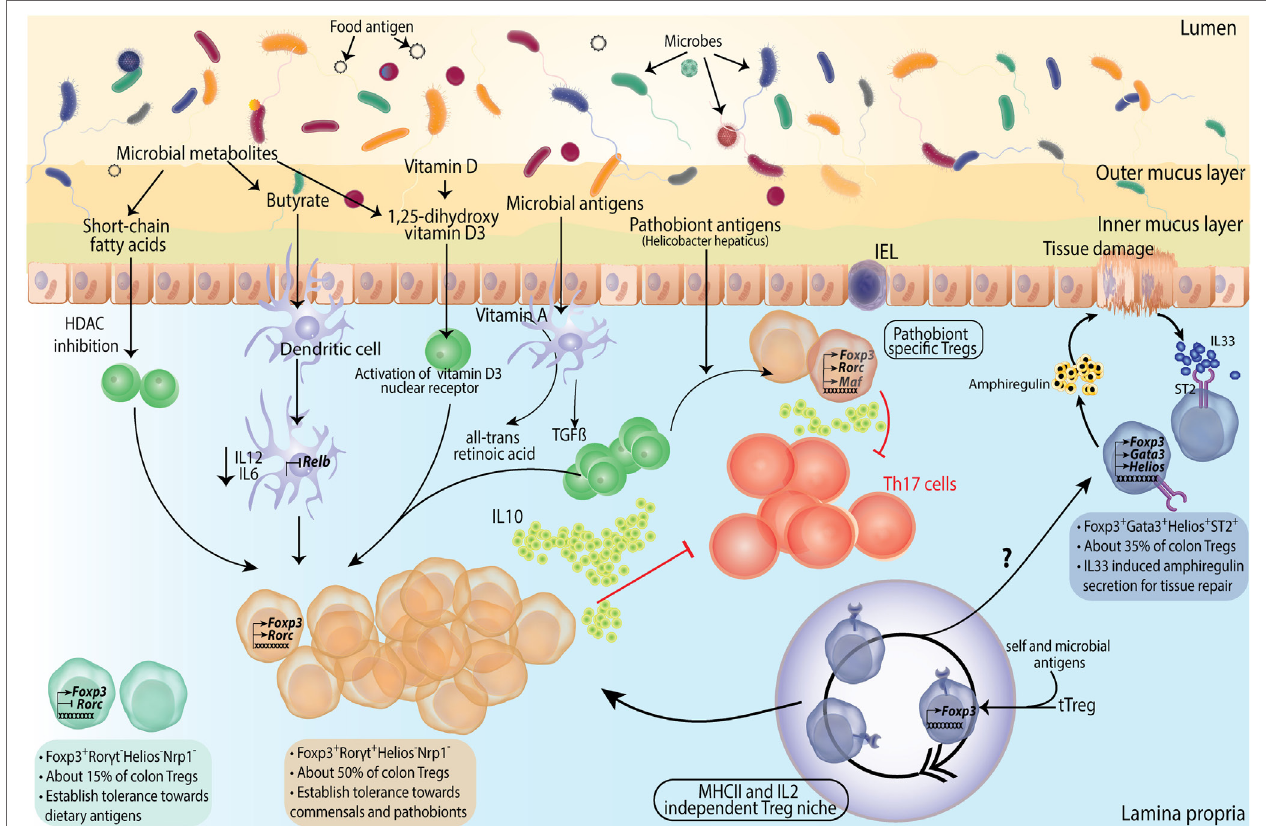
FiGURe 3 | Subtype differentiation of regulatory T-cells (Tregs) in large intestine. Colonic Tregs differentiate into three different subtypes based on ROR γ t (Rorc) and GATA3 expression along with Foxp3. Foxp3 + ROR γ t − cells comprise ~ 15% of colonic Tregs, their function in colon is not much elucidated but presumably these are responsible for establishing tolerance to dietary antigens. Second and major subset of colonic Tregs is Foxp3 + ROR γ t + Tregs, constituting about 50% of total colonic Tregs. These cells are primarily involved in microbial tolerance and several mechanisms contributing to their generation has been described. From left, short chain fatty acids generated by microbial fermentation can differentiate naive T cells into Foxp3 + ROR γ t + Tregs in lamina propria (LP). Butyrate, specifically, can contribute to Foxp3 expression and function by virtue of its histone deacetylase (HDAC) inhibitory function, as well as can turn dendritic cells (DCs) into Treg generating tolerogenic cells by suppressing their IL12 and IL6 levels and expression of NF κ B subunit Relb. Vitamin D metabolite 1,25-dihydroxy vitamin D3 differentiates naive T cells into Tregs by activating its nuclear receptor. TGF β along with DC generated vitamin A metabolite all-trans retinoic acid differentiates naive T cells into Tregs in presence of microbial antigens. Foxp3 + ROR γ t + Tregs deploy various mechanisms toward establishing dominant tolerance with IL10 production and direct suppression of Th17 cells as prominent ones. A special subset of Foxp3 + ROR γ t + Tregs express cMAF and is instrumental in establishing tolerance to pathobionts in homeostasis. Foxp3 + ROR γ t + cMaf + Tregs are identified against specific epitopes of Helicobacter hepaticus and suppress epitope specific Th17 cells. It has been shown that in absence of pTregs, early seeding of thymic Tregs (tTregs) happens in colonic LP. These tTregs expand into a niche which is independent of MHCII and IL2 signaling but depends on microbial antigens. These Tregs subsequently fill up the LP Treg compartment. However, whether these can differentiate into all Treg subtypes is not known. A third subtype of Tregs express GATA3 (not ROR γ t) and constitutes about a third of total Tregs. These Foxp3 + GATA3 + Tregs express ST2 receptor which bind to tissue damage-induced alarmin IL33. Foxp3 + GATA3 + Tregs are instrumental in suppressing inflammation and facilitating tissue repair by secretion of amphiregulin upon tissue